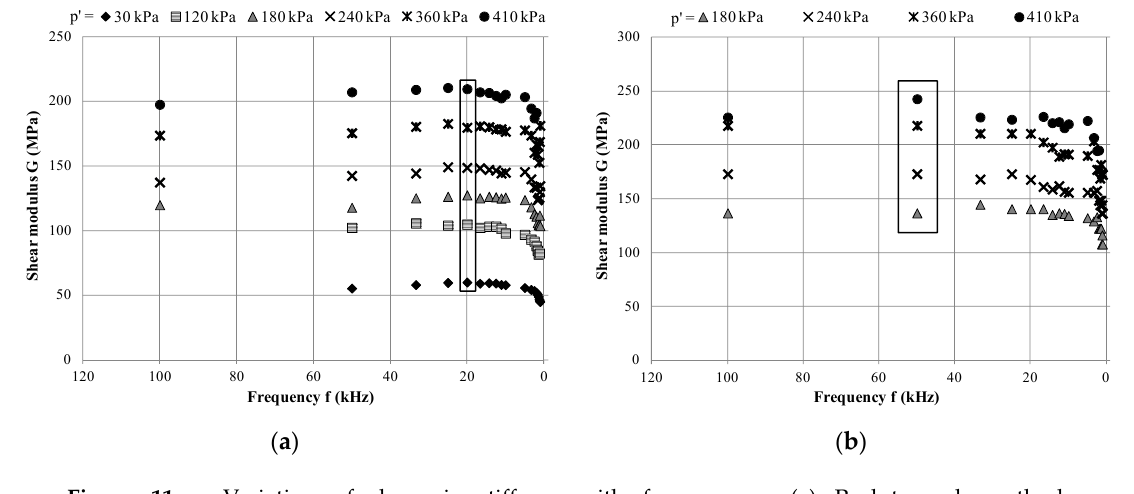
Figure 11. Variation of dynamic stiffness with frequency. ( a ) Peak-to-peak method; ( b ) start-to-start method.